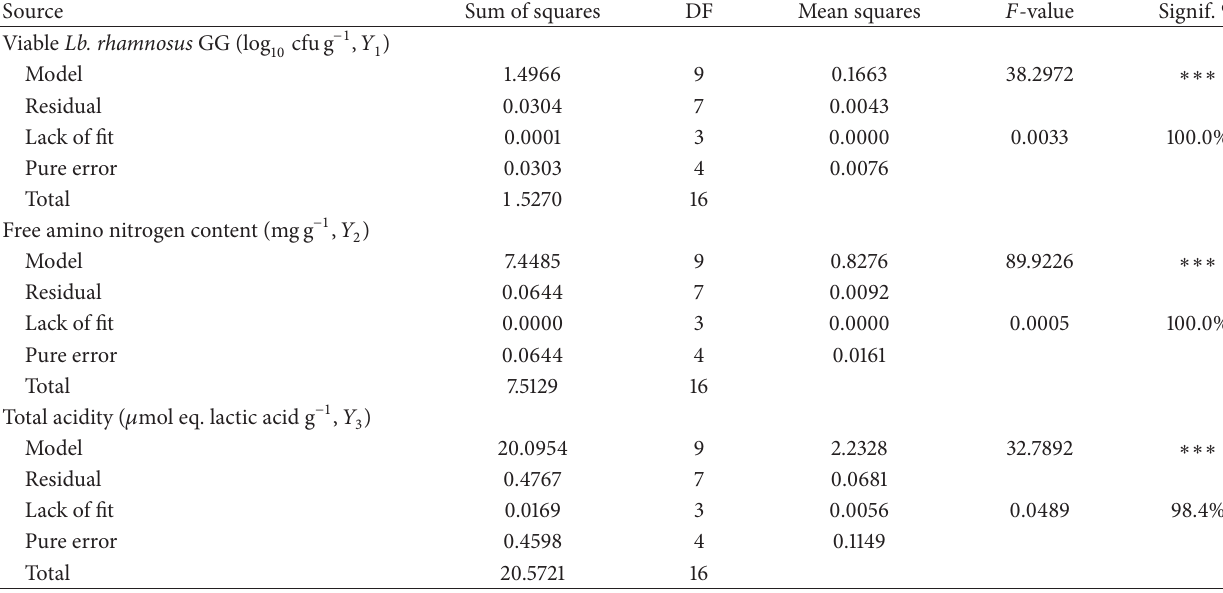
Table 4: Analysis of variance and regression analysis.